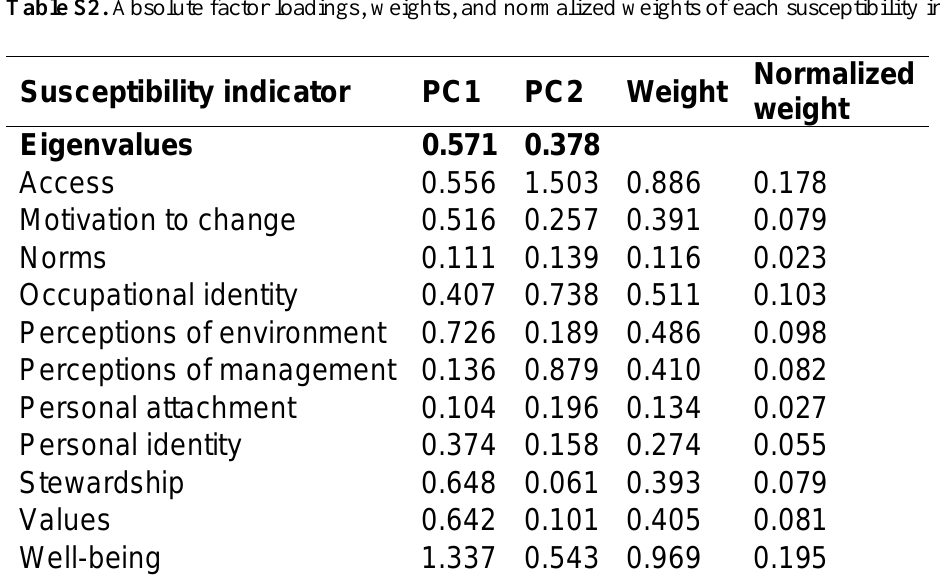
Table S2. Absolute factor loadings, weights, and normalized weights of each susceptibility indicator on PCA